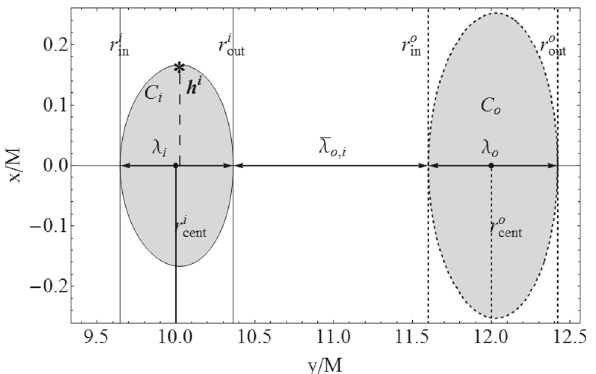
Fig. 7 Cross sections on the equatorial plane of the consecutive Boyer surfaces of two separated rings C i < C o , with boundaries ∂ C i and ∂ C o , the tori centers r min = r cent are signed with points and the lines r cent = (cid:4) x 2 + y 2 and ( x , y ) are Cartesian coordinates. constant. With r / M = The inner r in and outer r out edge are also signed, λ a for a ∈ { i , o } are the tori elongation and ¯ λ o , i is the spacing among the tori. h i is the height associated to the C i torus, or the maximum point of the surface ∂ C (cid:4) corotating rings, rotate around a black hole attractor with i The spin a = 0 . 75 M and specific angular momentum (cid:4) i = − 4 . 2897 and = − 4 . 41883 (cid:4) o